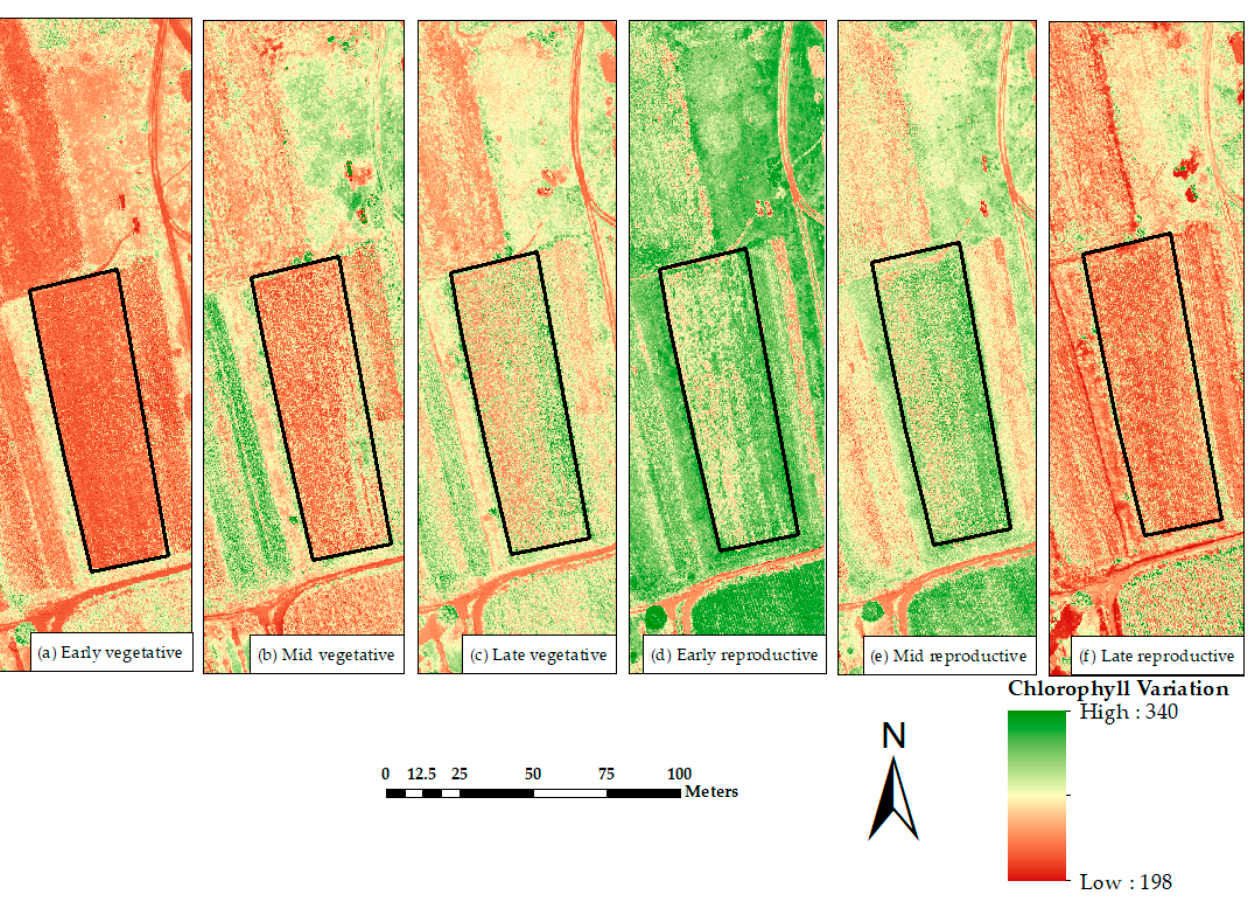
Figure 7. Spatial distribution of chlorophyll content over the maize field for vegetative stages ( a ) V5–V10, ( b ) V12, ( c ) V14 to VT, and reproductive stages ( d ) R1–R3, ( e ) R3–R4, ( f ) R5–R6.